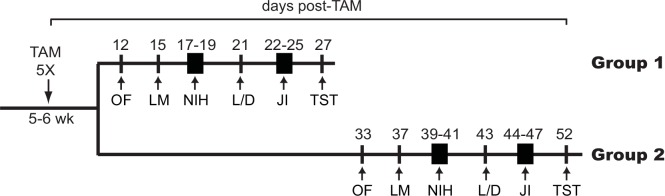
Experimental design of behavioral study.TAM was administered to 5–6 week-old control or Cre+DTA+ mice for 5 consecutive days. Behavioral testing began 12d (Group 1) or 33d post-TAM (Group 2), and continued as indicated through day 27 (Group 1, TAM-behavioral [TAM-beh] interval less than 4 weeks) or day 52 (Group 2, TAM-beh interval more than 4 weeks) post-TAM. Both groups were examined in the open field test (OF), locomotor test (LM), novelty induced hypophagia (NIH), light/dark test (L/D), juvenile social interaction test (JI), and tail suspension test (TST). Specifically for Groups 1 and Groups 2, OF was performed 12d or 33d post-TAM, LM 15d or 37d post-TAM, NIH 17-19d or 39-41d post-TAM, L/D 21d or 43d post-TAM, JI 22-25d or 44-47d post-TAM, and TST 27d or 52d post-TAM.